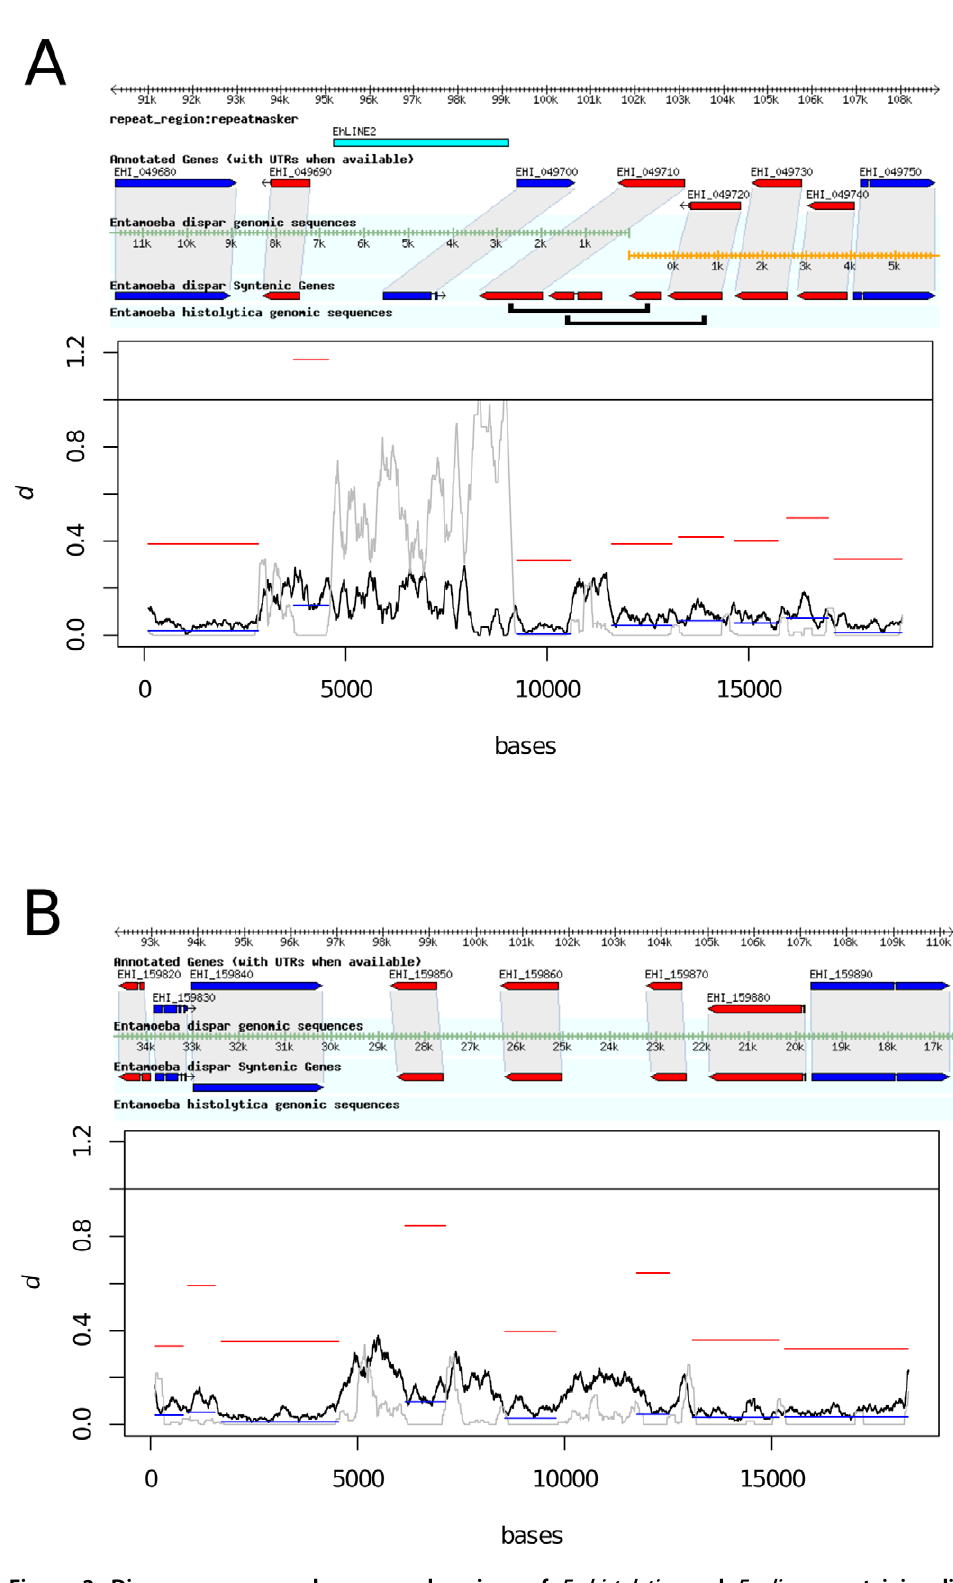
Figure 2. Divergence across chromosomal regions of E. histolytica and E. dispar containing light-chain lectin genes. (A) lgl (EHI_049690:EDI_071530); (B) lgl (EHI_159870:EDI_325130). Divergence ( d ) for a 200 bp sliding window is shown (black line), and dN (blue bars) and dS (red bars) are plotted for putative coding regions. The grey line shows the proportion of gapped positions in each window, an indication of poor alignment quality. Light-chain lectin gene EHI_049690 shows dS . 1, it occurs adjacent to a LINE2 sequence in E. histolytica . Black bars indicate putative genes merged by overlapping the two E. dispar scaffolds.